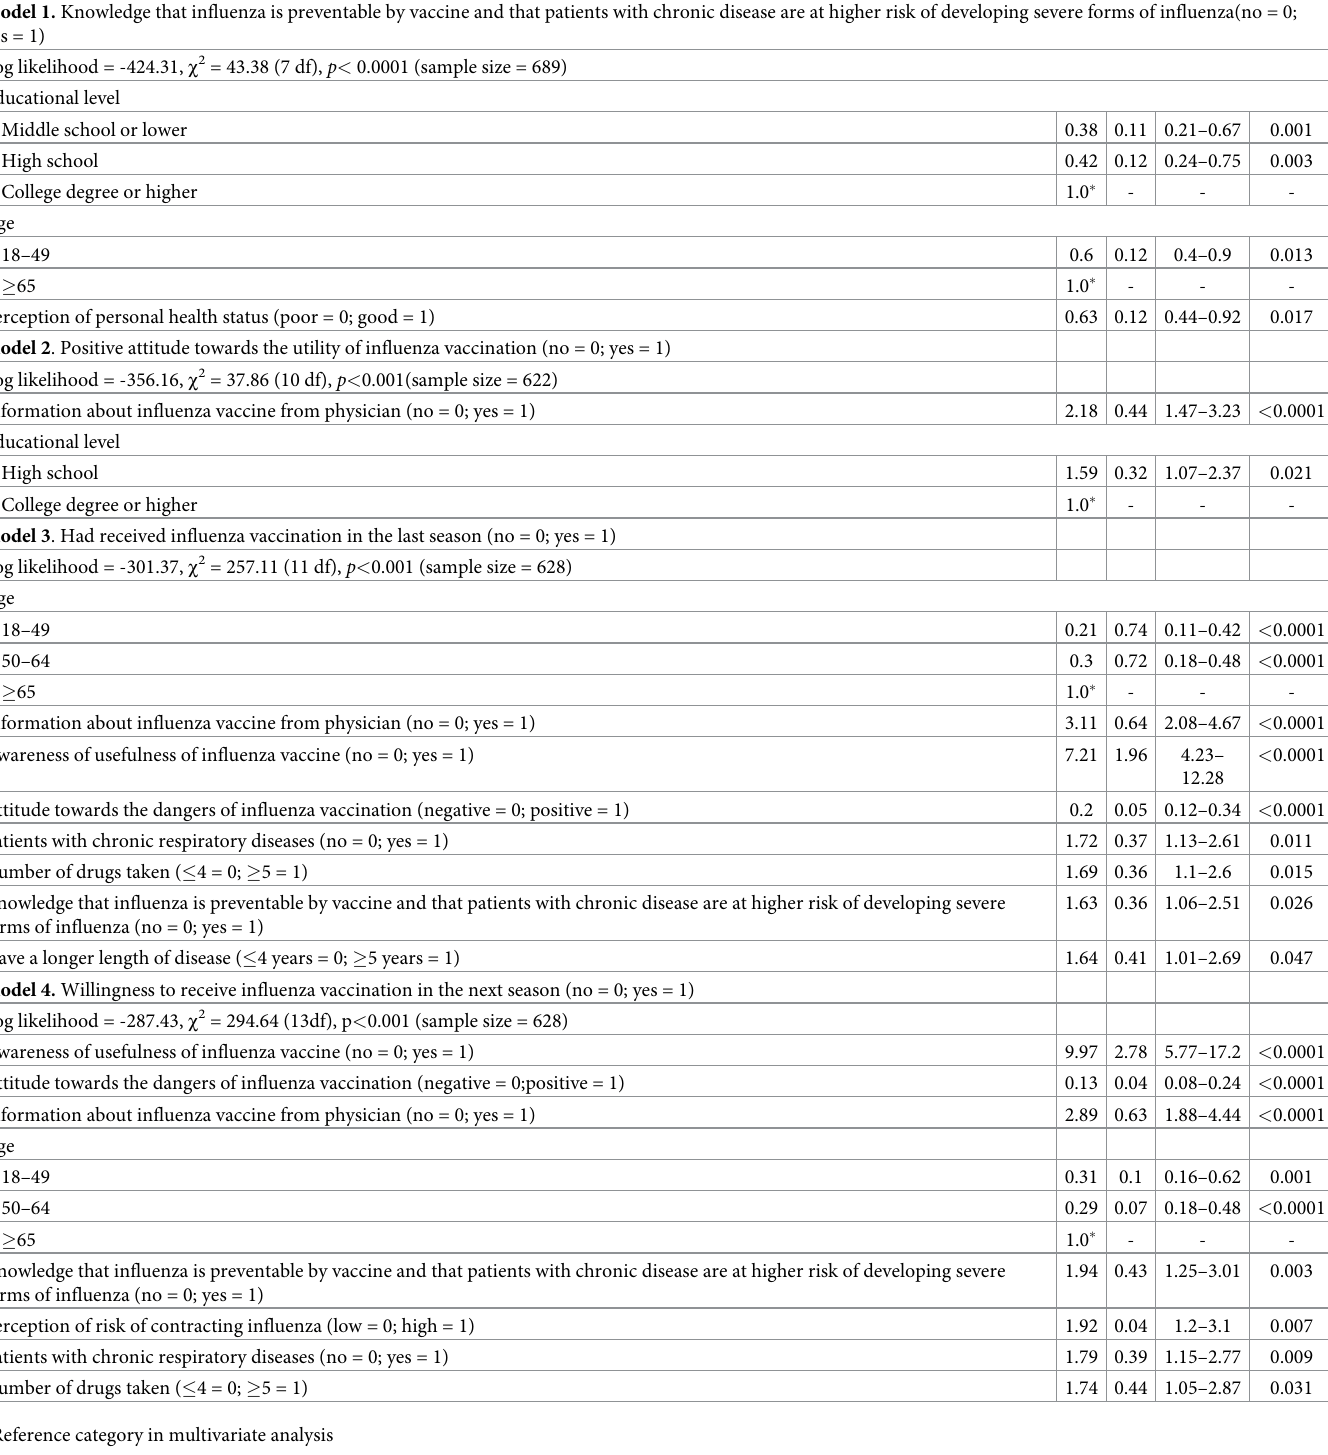
Table 2. Multivariate logistic analysis to characterize factors associated with different outcomes of interest. Variable OR SE 95% CI p value Model 1. Knowledge that influenza is preventable by vaccine and that patients with chronic disease are at higher risk of developing severe forms of influenza(no = 0; yes =